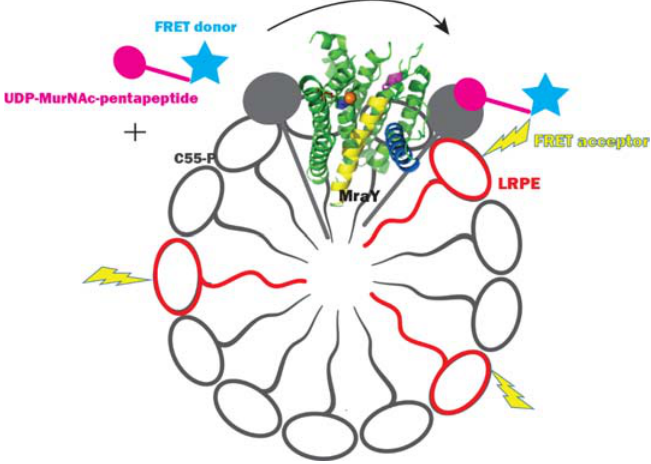
Figure 5. Fluorescence resonance energy transfer assay for MraY. The figure is adapted from